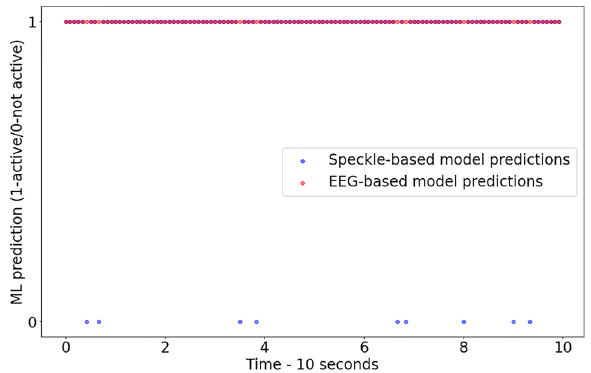
Figure 4. Comparison between the optical and EEG ML sense activity predictions. The predictions are based on simultaneous 10 s speckle and EEG inputs for one of the subjects while the sense of smell was active. The X-axis represents the time, and the binary EEG and speckle-based models’ predictions are shown on the Y-axis (0 when the sense is inactive and 1 when the sense is active).